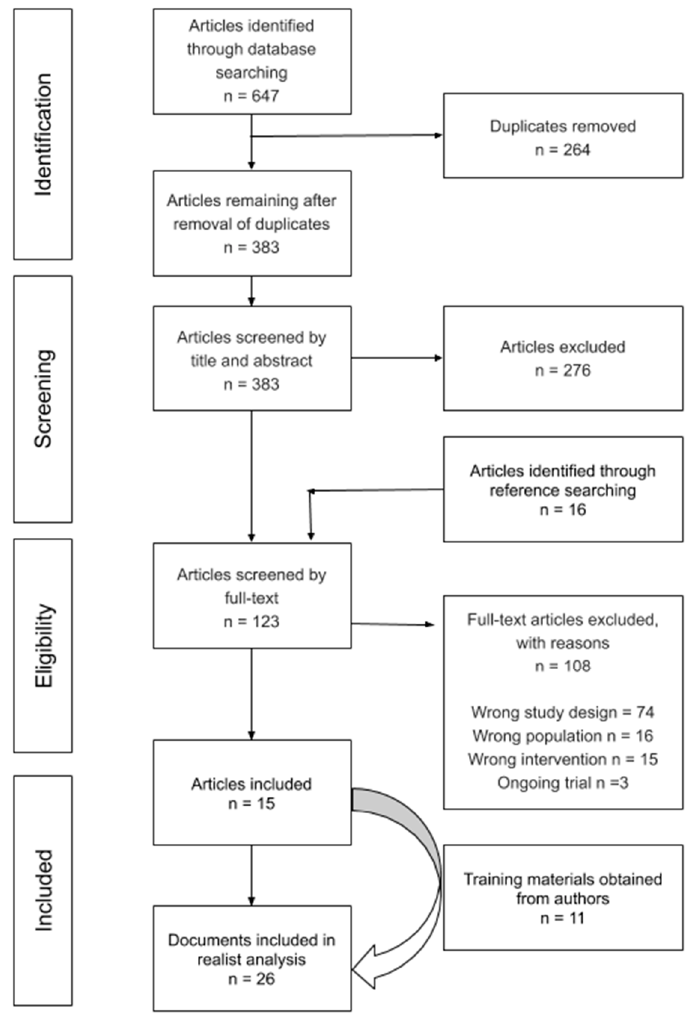
Figure 1. PRISMA flow diagram.